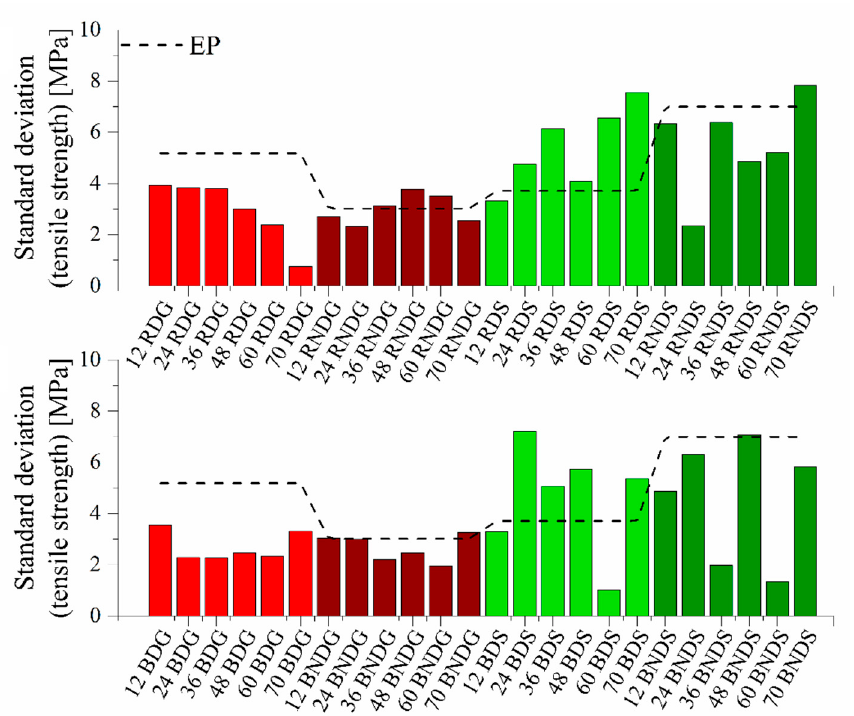
Figure 15. Standard deviations from the tensile strength value for systems containing base and fractionated diatoms.